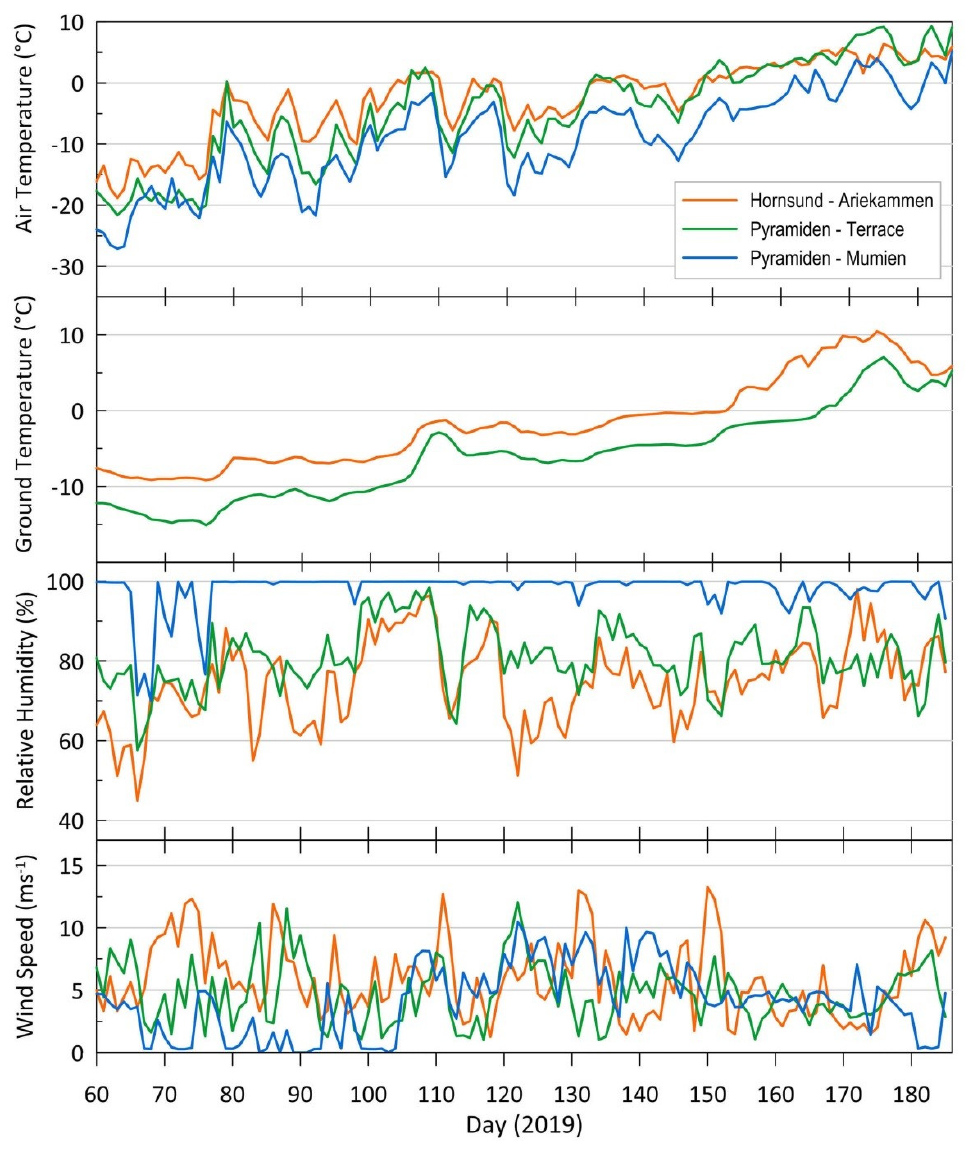
Figure 4. Basic meteorological parameters for both Hornsund and Pyramiden sampling sites recorded in the period 1 March–4 July 2019 (day 60–185).